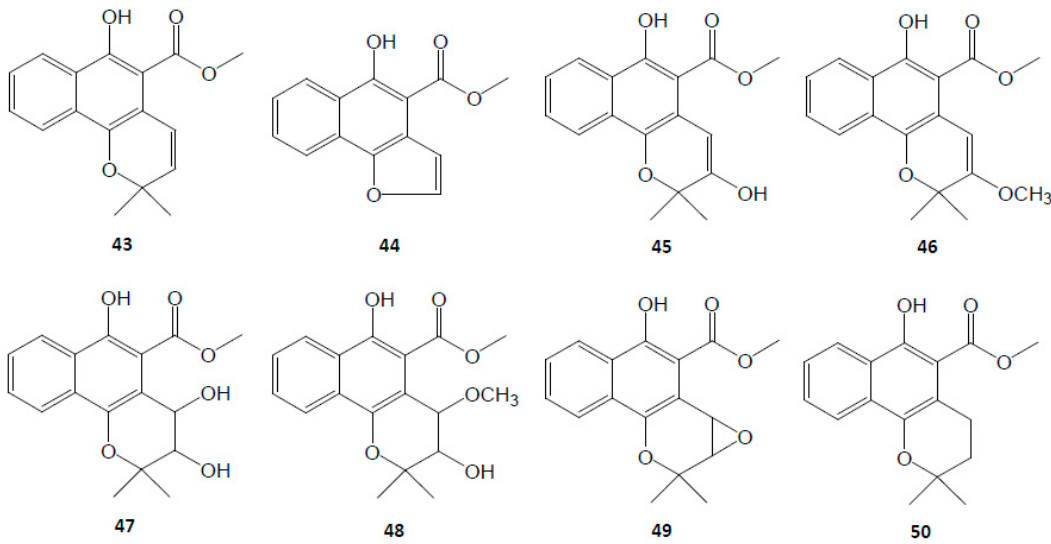
Figure 3. Structures of naphthoquinones in Rubiae Radix et Rhizoma.